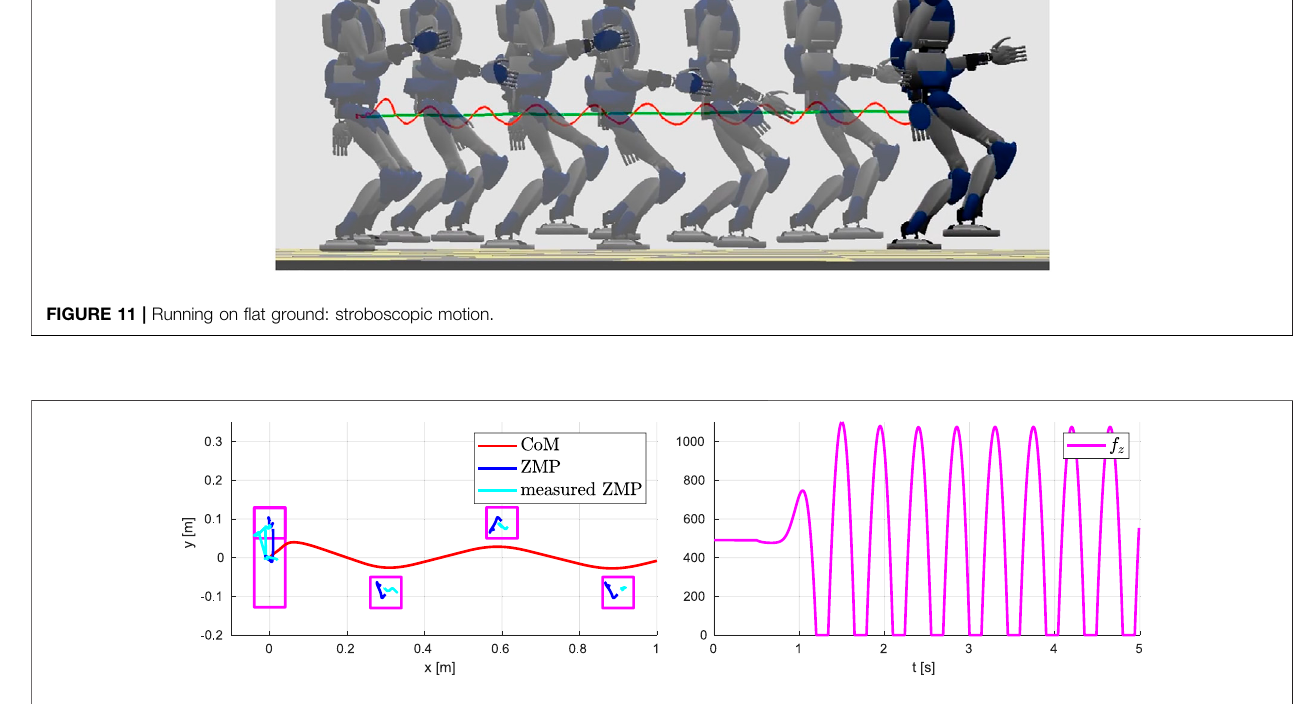
FIGURE 12 | Running on fl at ground: CoM/ZMP trajectories (left) and vertical GRF (right).